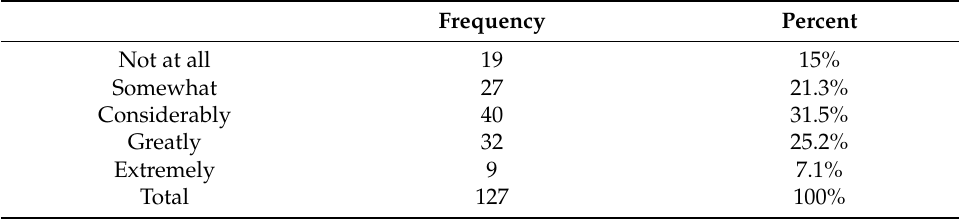
Table 3. Level of satisfaction with the Compensation and Benefits Package.